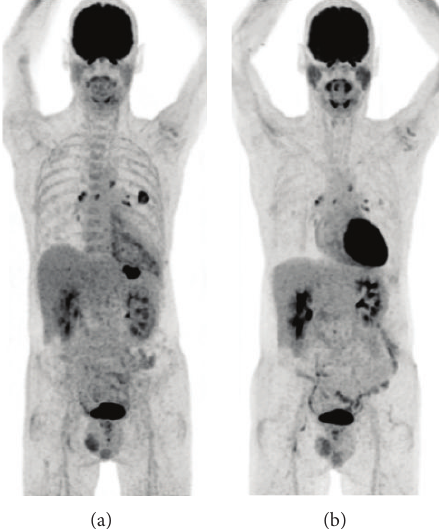
Figure6:FDG-PETofaneutropenicpatient(duetoleukemia)withafungalinfection(aspergillosis)before(leftimage)andduringantifungal therapy (right image) resulting in a decrease in FDG uptake in the lung lesions. Because on the last FDG-PET scan (right image) there is still no complete remission, the patient is still treated with antifungal